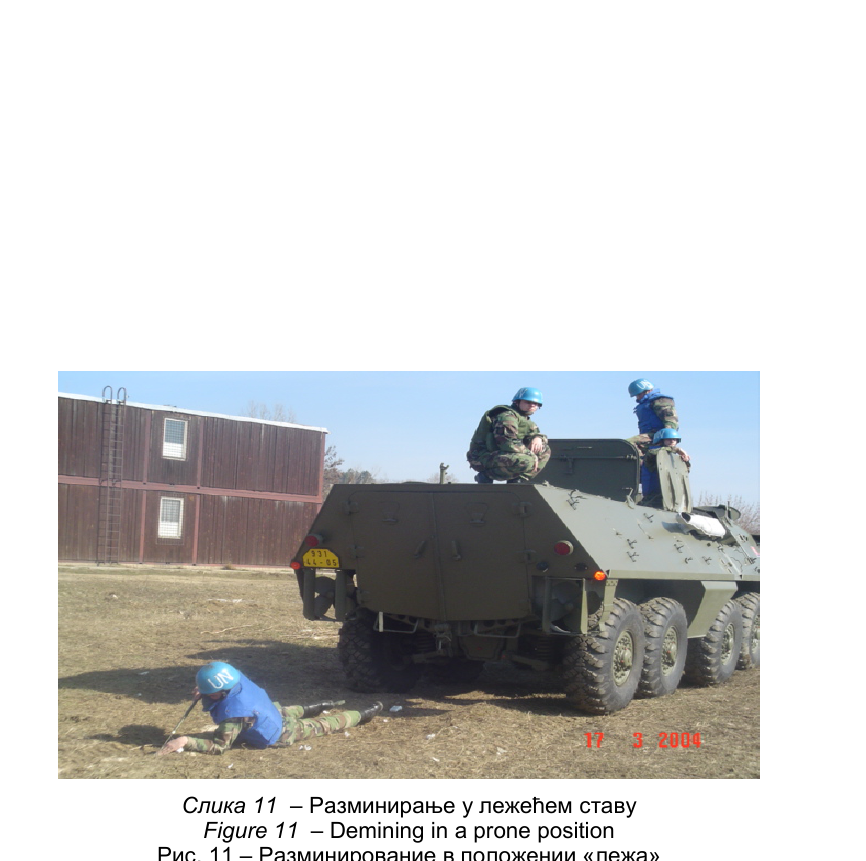
Figure 11 – Demining in a prone position Рис . 11 – Разминирование в положении « лежа